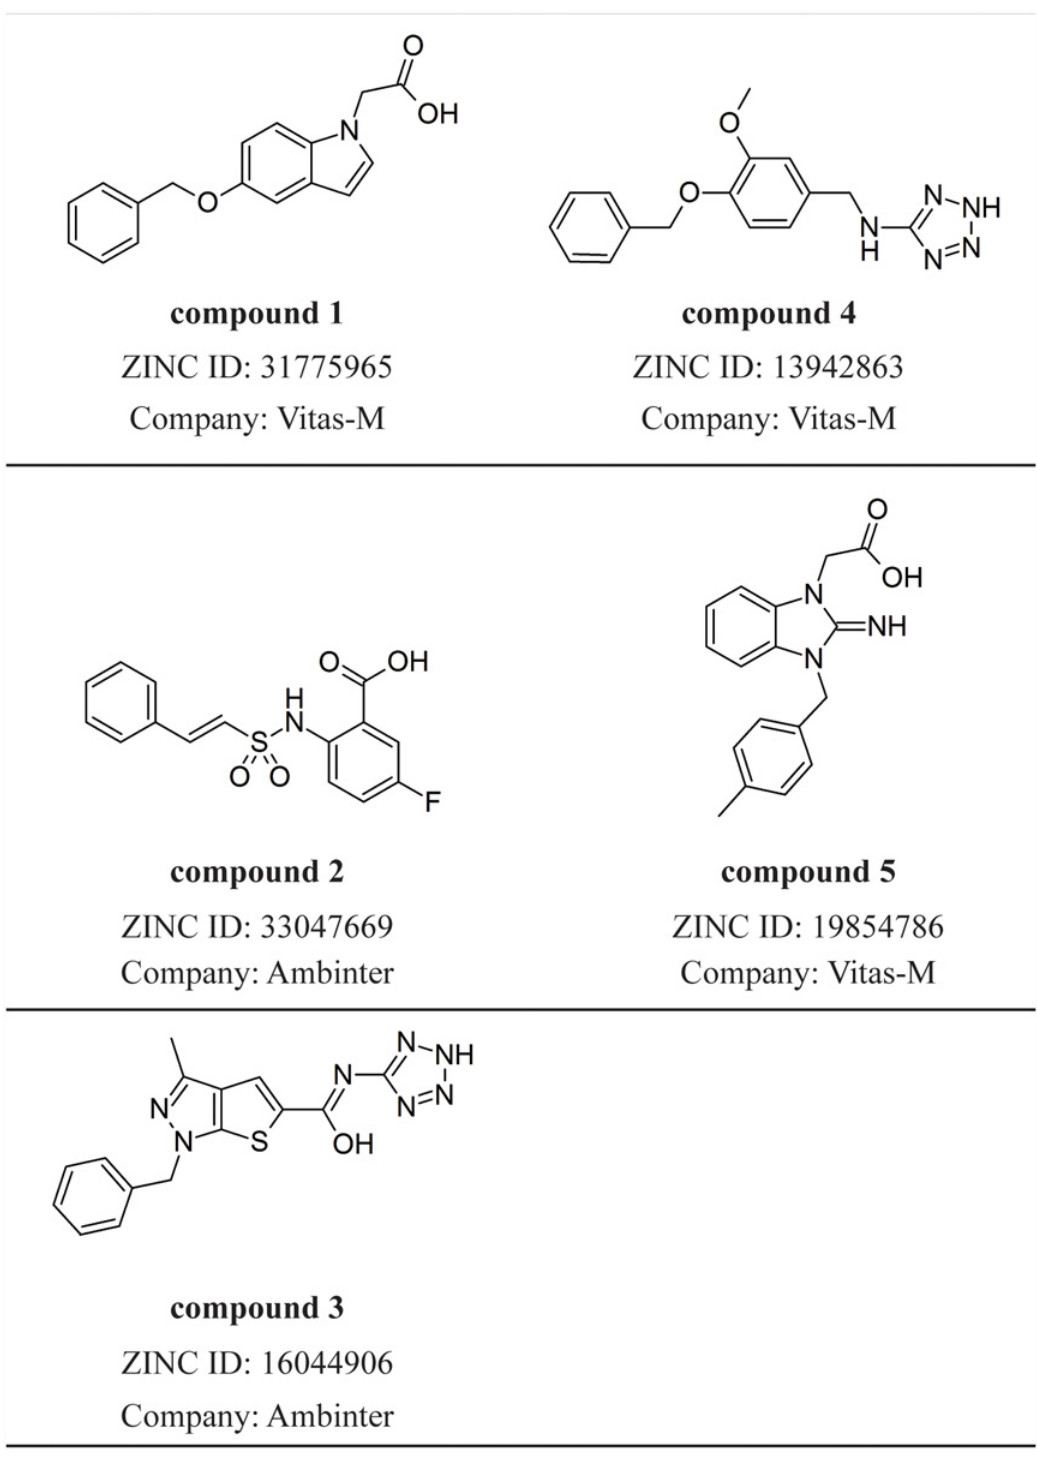
Fig 1. Compounds selected by VS protocol.